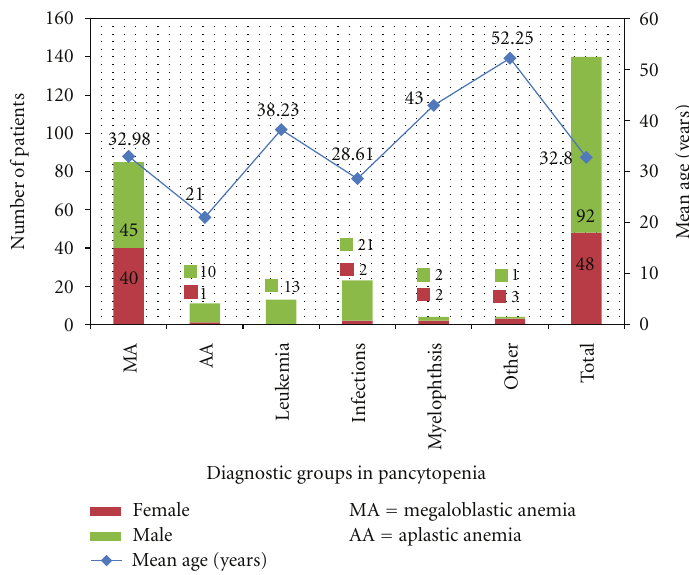
Figure 2: Age and gender distribution across diagnostic groups in pancytopenia.